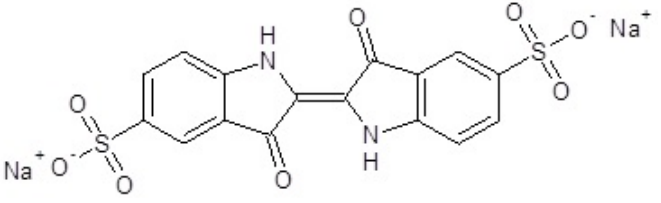
Figure 1. Indigo carmine molecule ((2E)-3-oxo-2-(3-oxo-5-sulfonato − 1,3-dihydro-2H-indol-2- ylidène)-5-indolinesulfonate de